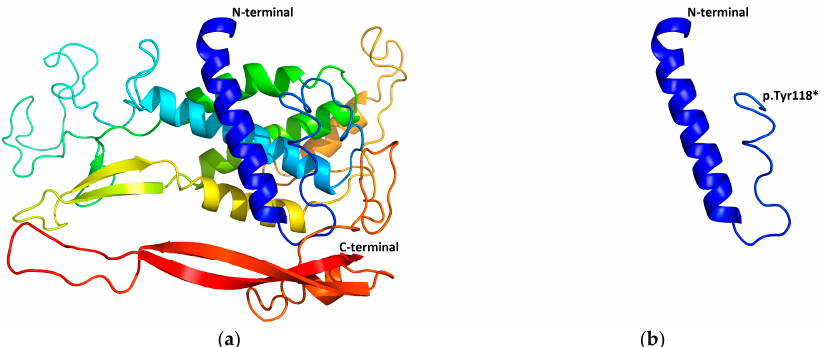
Figure 5. The structure of protein Wnt ‐ 8 (PDB ID 4F0A) was used as a homology model to perform structural modeling of the ( a ) wild ‐ type Wnt ‐ 10a and ( b ) p.Tyr118* mutated Wnt ‐ 10a. The mutated Wnt ‐ 10a protein was unlikely to have any function with the majority of the protein structure lost.